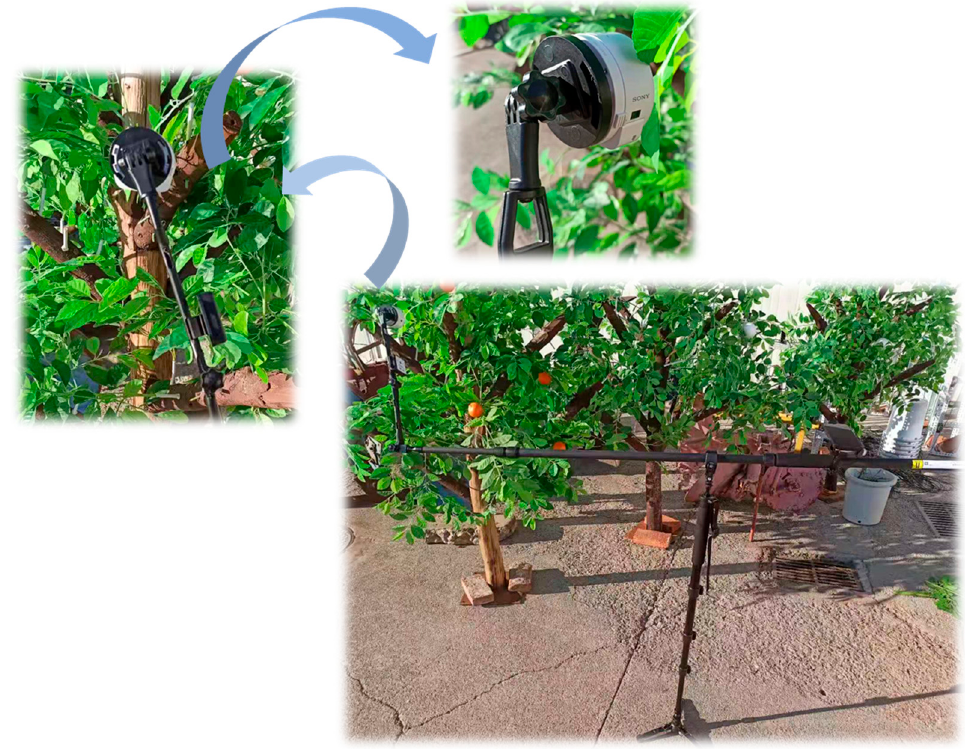
Figure 3. Hardware system module.